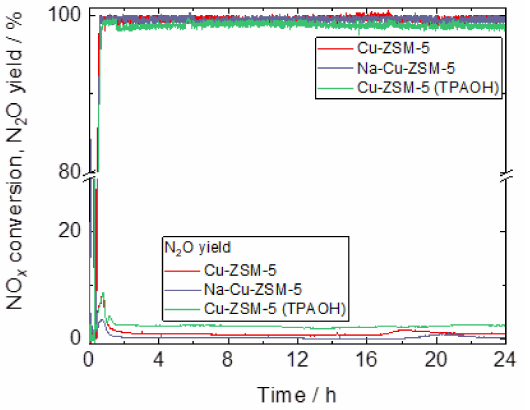
Figure 13. NO conversion and N 2 O yield during NH 3 -SCR over the Cu-exchanged ZSM-5 (reaction conditions: 0.2 g of catalyst, 120 mL min − 1 , 500 ppm NO, 575 ppm NH 3 , 4 Vol.% O 2 , 5 Vol.% H 2 O, and He balance, GHSV = 30,000 h − 1 , 350 ◦ C, 24